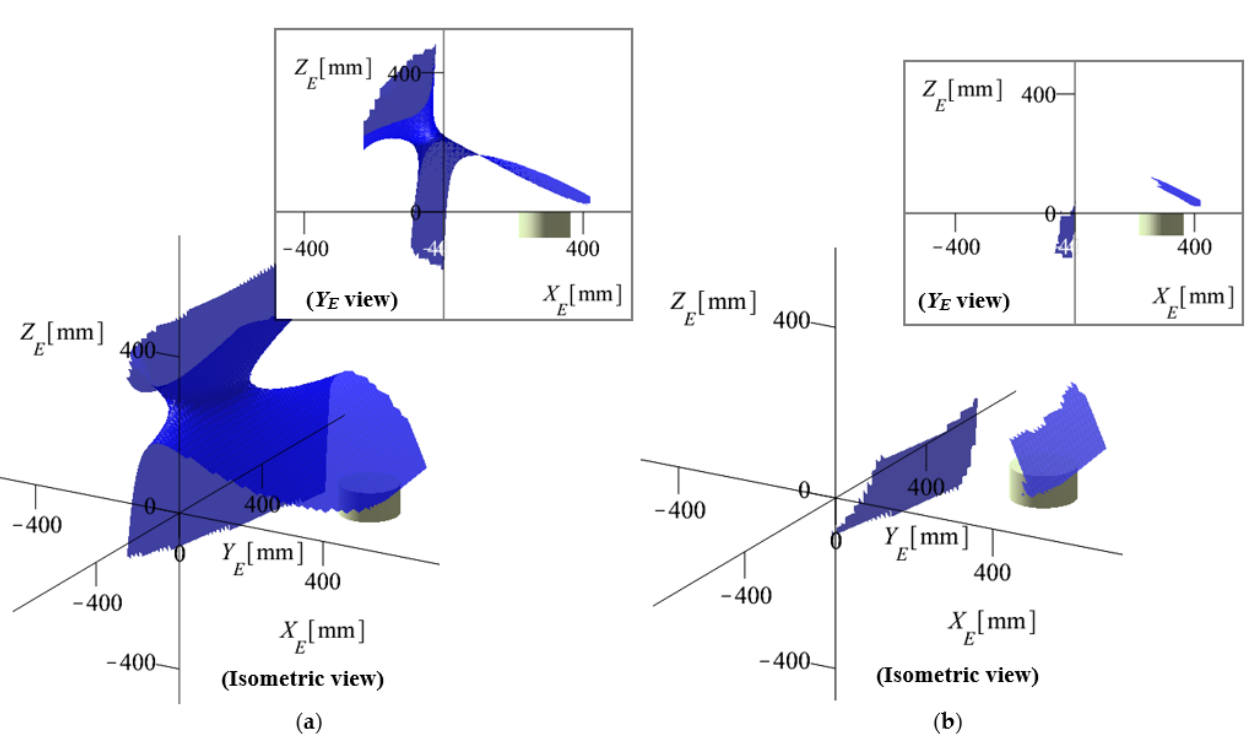
Figure 21. Output singularity surface for { ψ = 20, θ = 0, φ = 0} [°]: ( a ) without the inverse kinematic model constraints; ( b ) with the inverse kinematic model constraints.